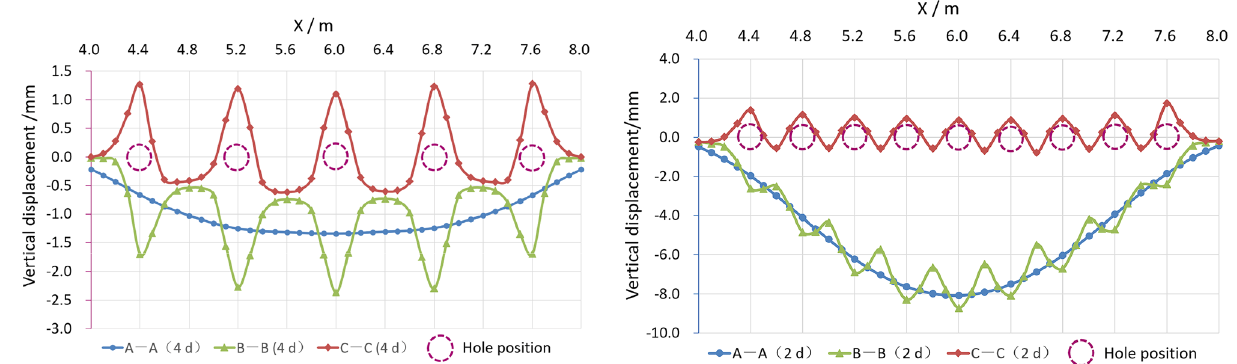
Fig. 9 Comparison of vertical displacements at different horizontal